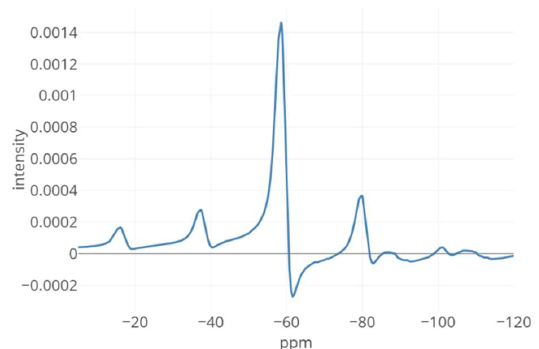
Figure 2. The ssNMR mixture spectrum of a spiked sample of amorphous material containing 3% of a crystalline solid-state form. Among other factors mentioned in the Introduction, the multiple sidebands, broad peaks due to the dominant amorphous component, and processing artifacts such as considerable phase error necessitate a tailored deconvolution